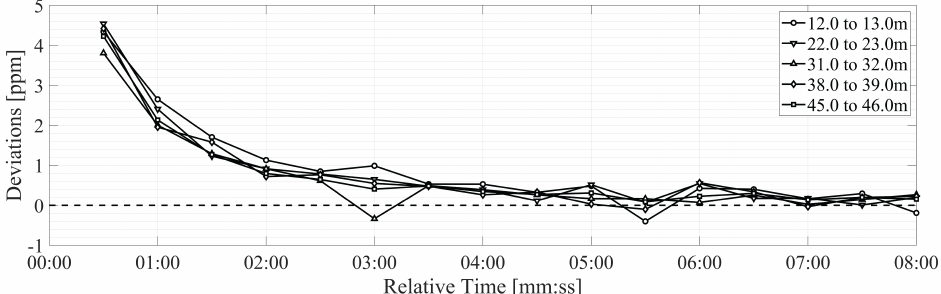
Figure 11. Deviations in parts per million for various